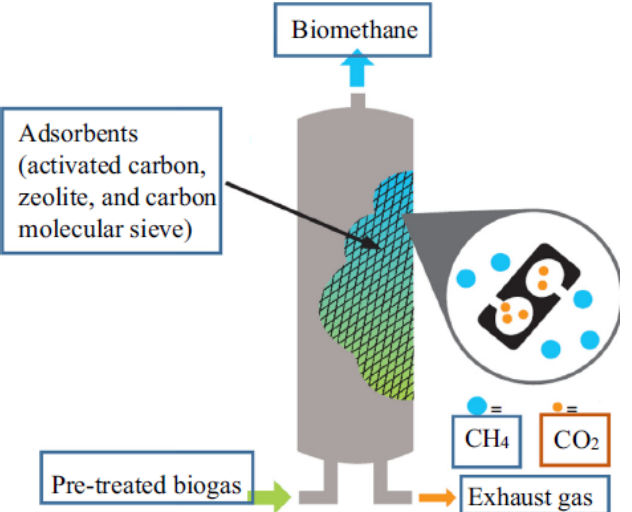
Figure 12. Scheme of the PSA process [93].